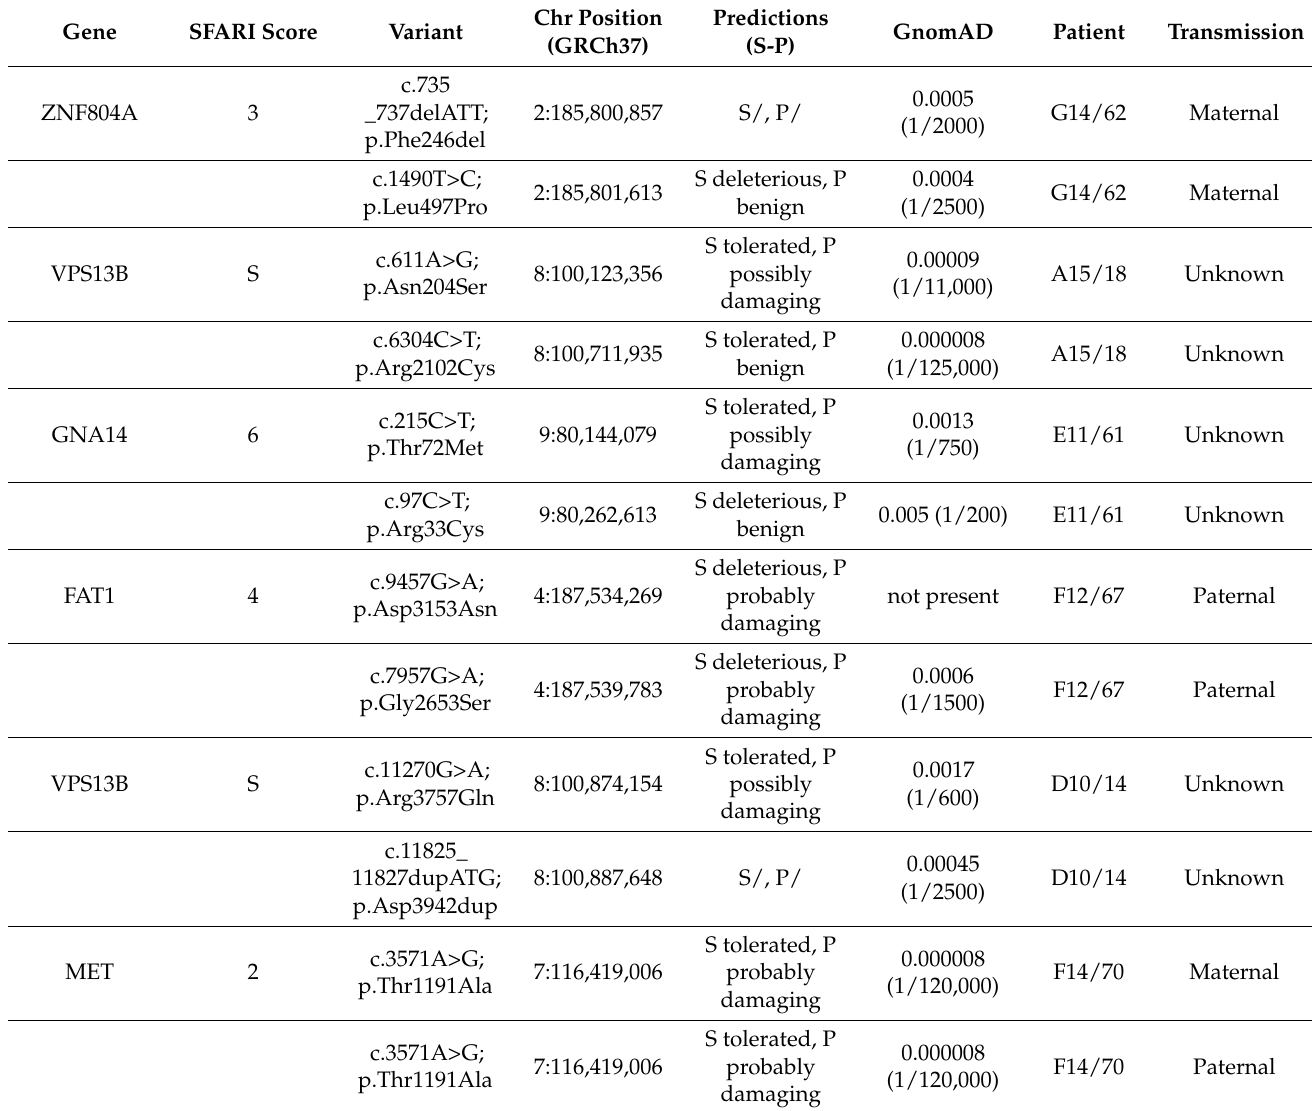
Table 8. Variants that are in the same gene and in the same